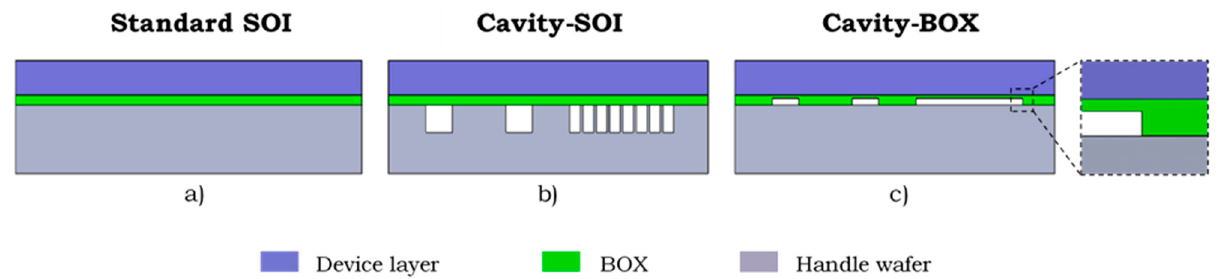
Figure 1. A comparison of three substrate architectures: ( a ) Standard SOI substrate; ( b ) Cavity-SOI substrate with cavities in handle wafer; ( c ) Cavity-BOX substrate with the pre-patterned buried oxide layer.